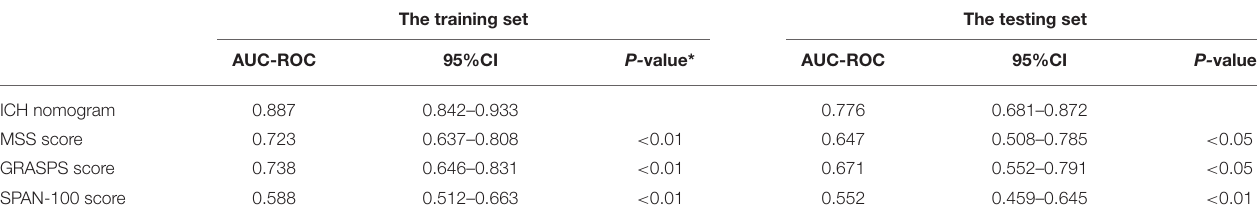
TABLE 4 | The comparison of AUC-ROC of the ICH nomogram, MSS scores, and GRASPS scores for predicting the risk of ICH in the training set and testing set. The training set The testing